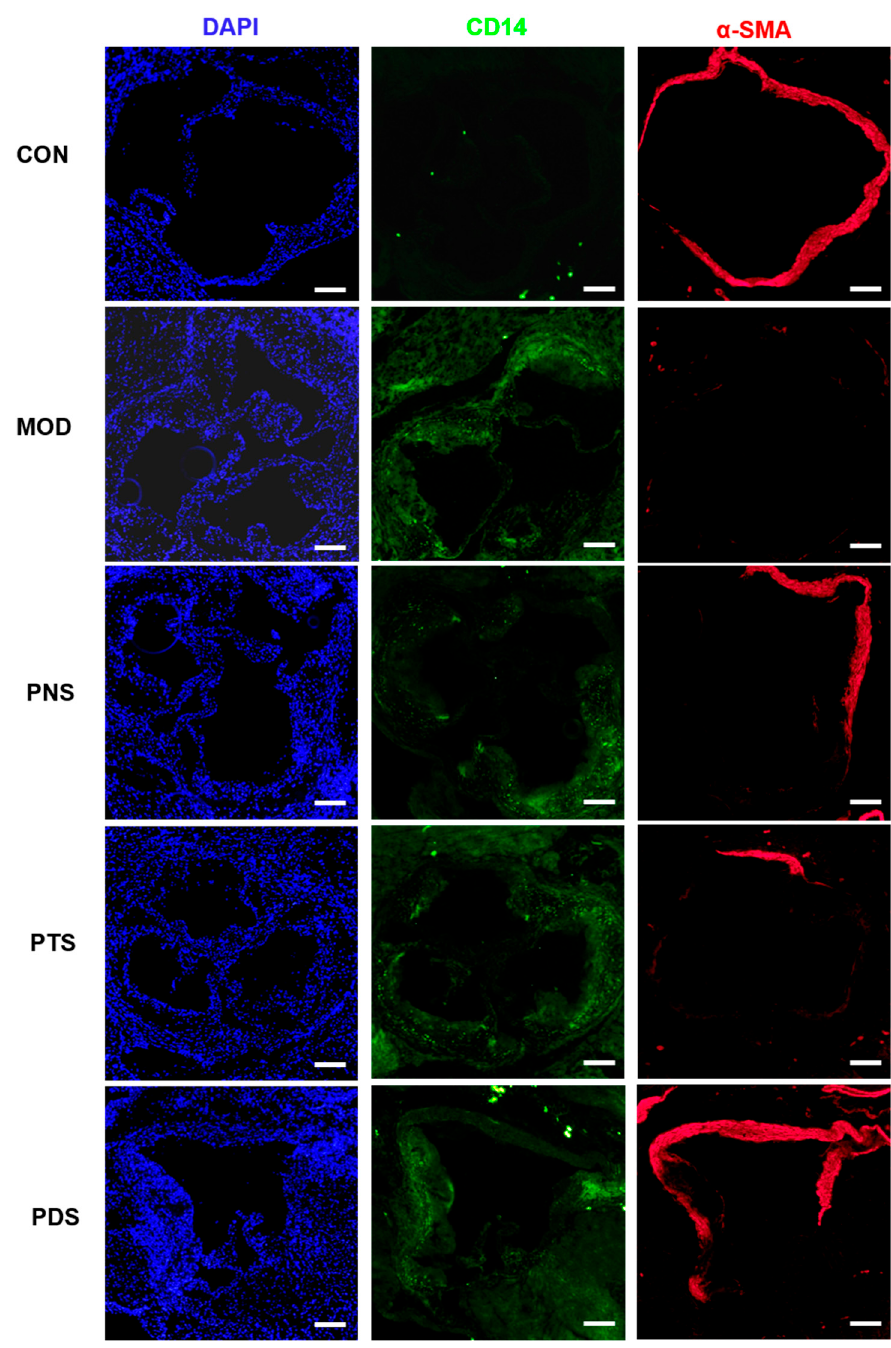
Figure 5. Representative immunofluorescent staining of DAPI (blue), CD14 (green), and α -SMA (red) in the cross section of the aortic sinus. Scale bar, 200 μ m.